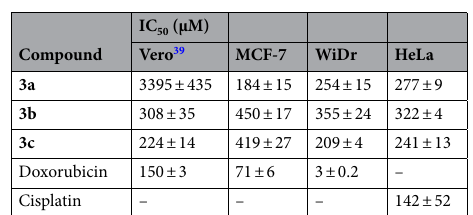
Table 2. In vitro anticancer activity of hydroxyxanthone